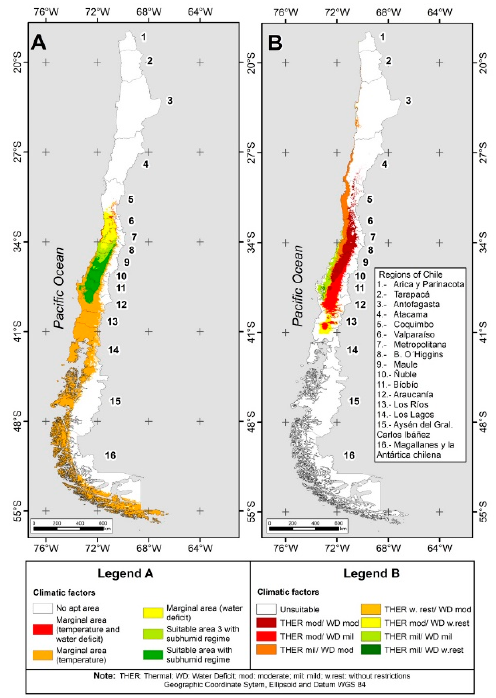
Figure 1. Suitability zoning for castor bean in Chile according to the simplistic method ( A ) and presence-species method ( B ). Therm: Thermic; WD: Water deficit; mod: Moderate: mil: Mild; w. rest: Without restriction.